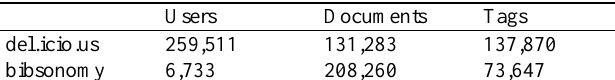
Table 2. Statistics for two test